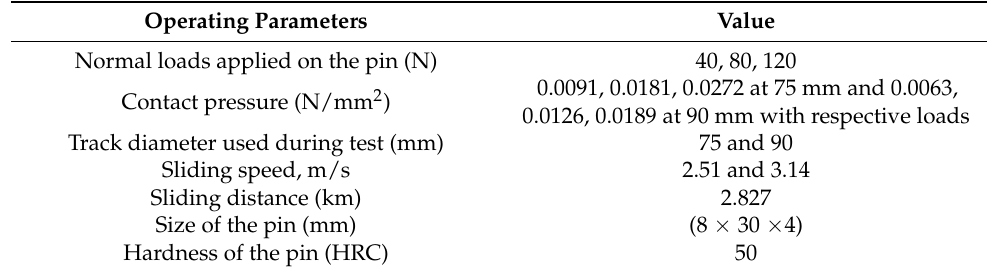
Table 3. Operating condition during